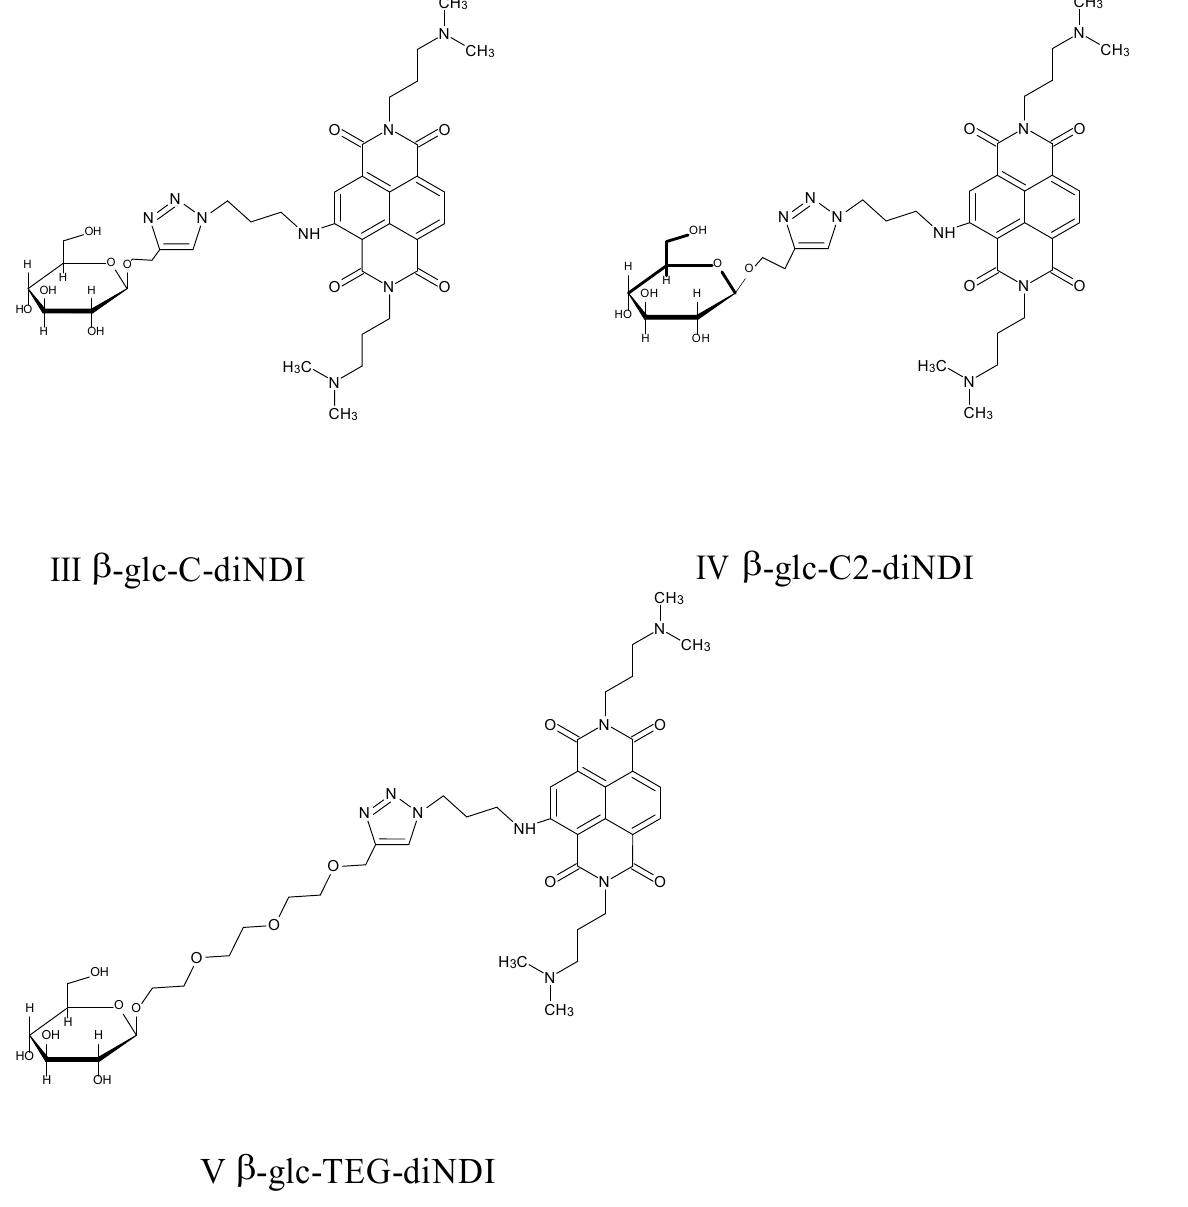
Figure 12. The structure of previously reported conjugates (I and II) and new conjugates (III, IV, V).